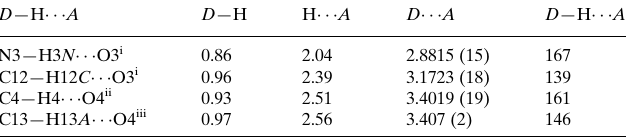
Hydrogen-bond geometry (A˚ , (cid:2)